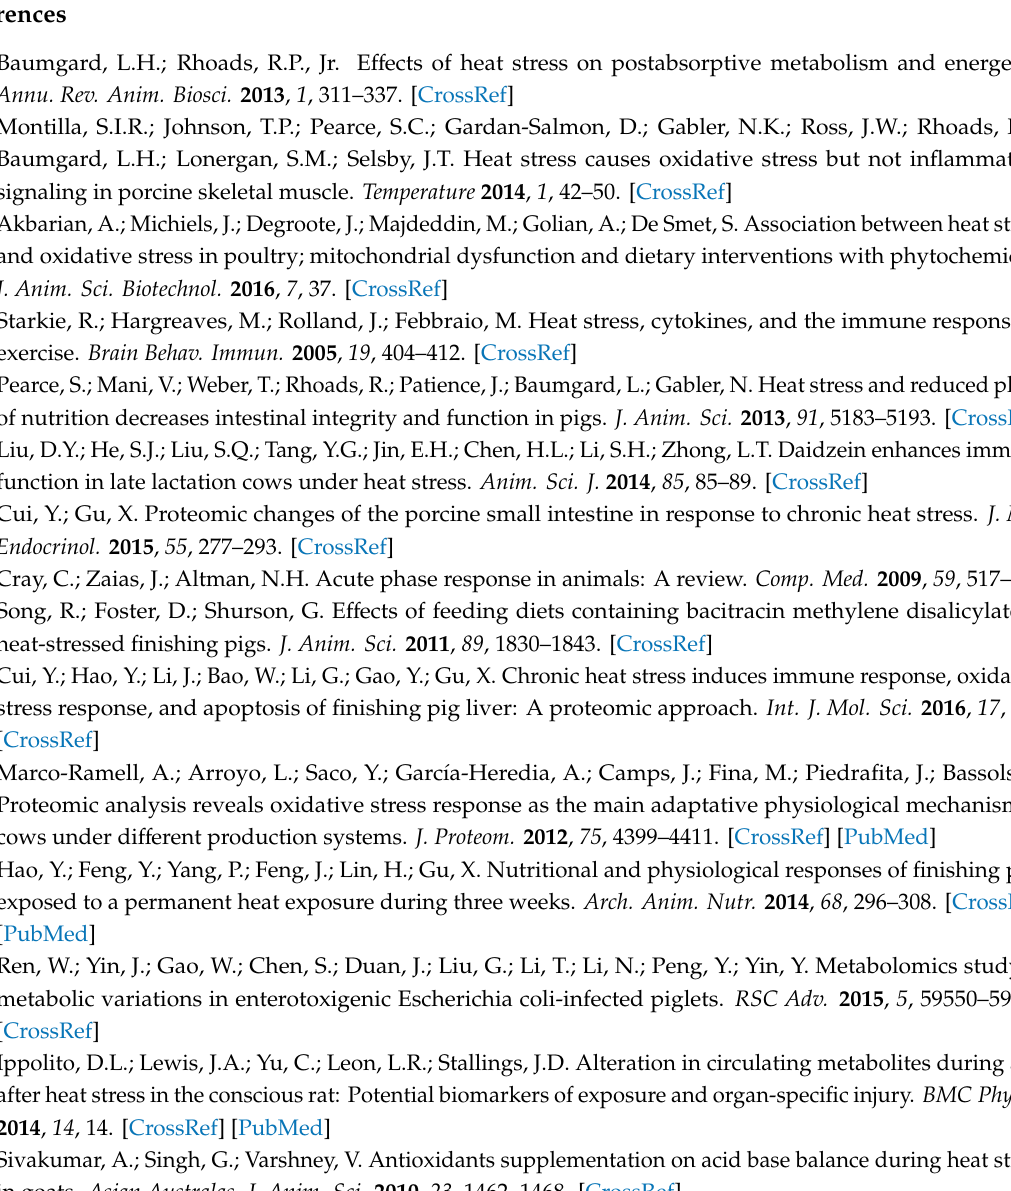
Table S1: Composition of the experimental